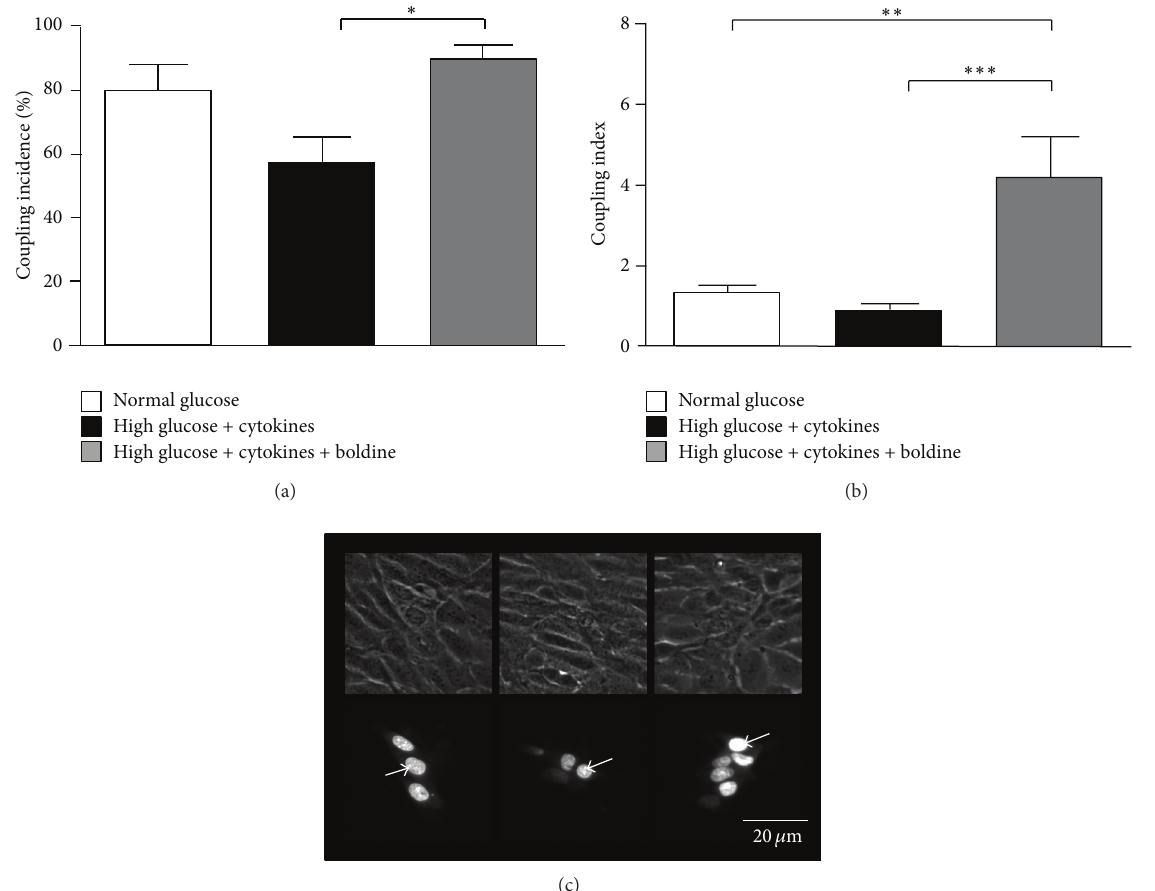
Figure 7: Boldine increases gap junctional coupling between mesangial cells. Coupling incidence (a) and coupling index (b) were evaluated in confluent mesangial cell cultures for 48h, under different conditions using the dye (Ethidium bromide) coupling technique: normal glucose (white bar), high glucose + cytokine (TNF- 𝛼 (10ng/mL) and IL-1 𝛽 (10ng/mL)) (black bar), or high glucose + cytokine treated with 100 𝜇 M boldine for the last 24 h (grey bar). Each bar represents the mean value ± SEM of 5 independent experiments. In each experiment the dye was microinjected into at least 10 cells. ∗∗ 𝑃 ≤ 0.01 ; ∗∗∗ 𝑃 ≤ 0.001 , using the one-way ANOVA test followed by Bonferroni’s post hoc test. (c) Etd was microinjected into the brightest cell (arrow) and diffused to neighboring cells. Normal glucose (left bottom), high glucose + cytokine (middle bottom), and high glucose + cytokine and treated with 100 𝜇 M boldine (right bottom) for 24 h. The top panels are the corresponding phase views. Scale bar = 20 𝜇